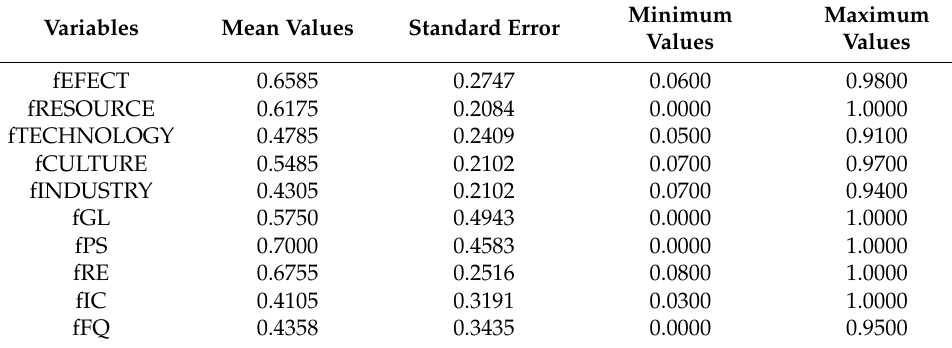
Table A2. Results of descriptive statistical